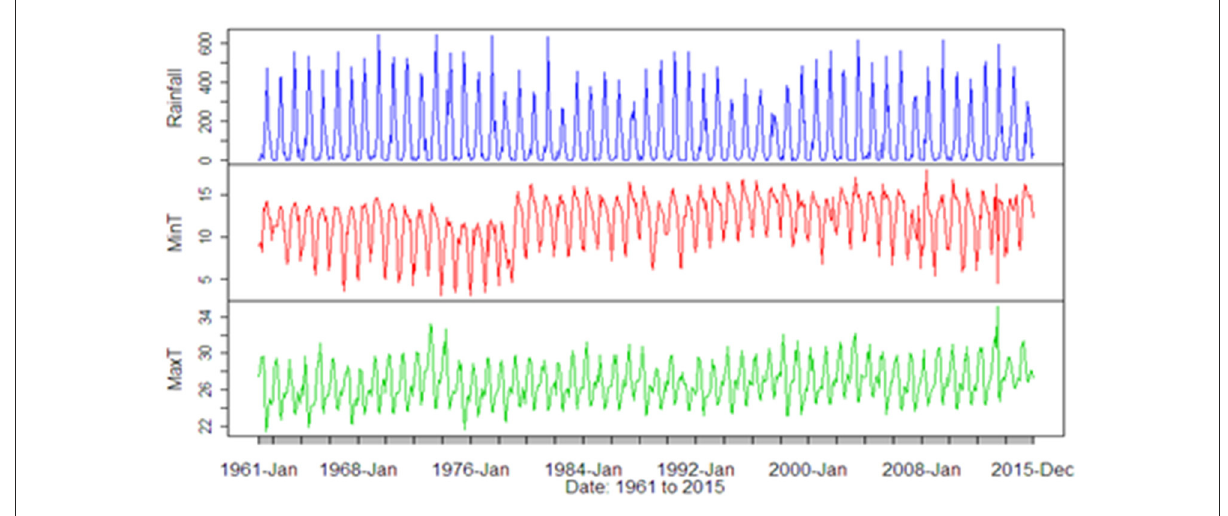
FIGURE2 Trend analysis of the monthly rainfall, minimum and maximum